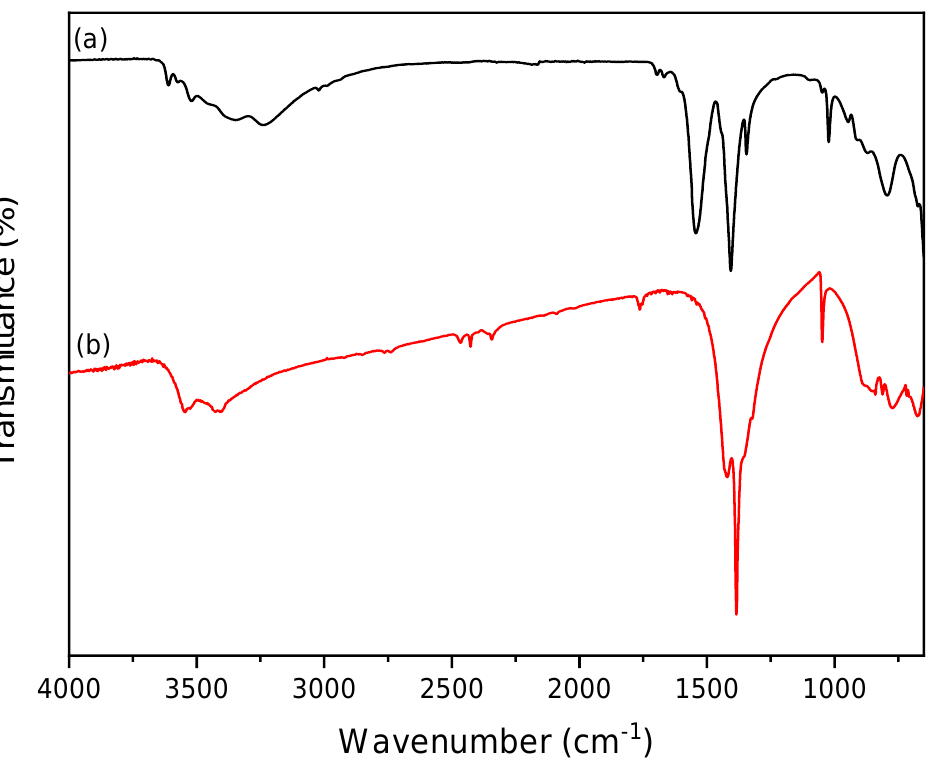
Figure 2. FTIR spectra of ( a ) copper hydroxy acetate and ( b ) copper hydroxy nitrate.